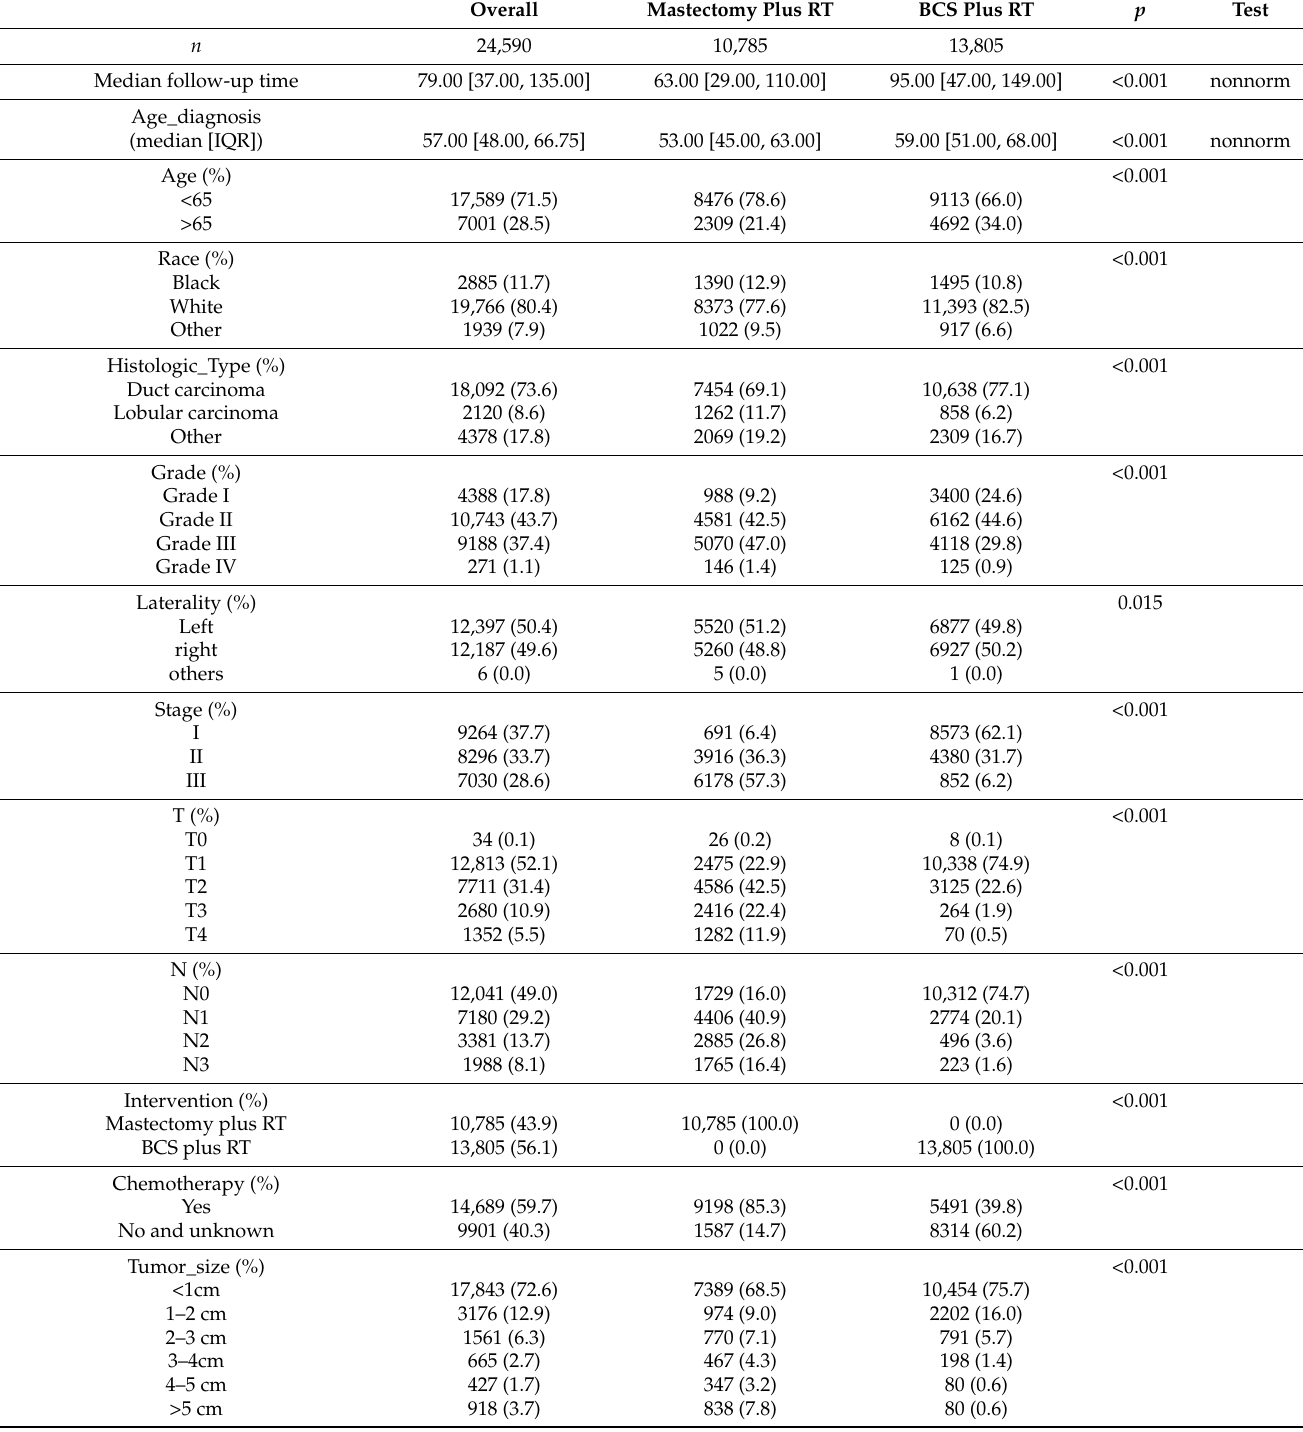
Table 1. Clinical characteristics of stage I–III